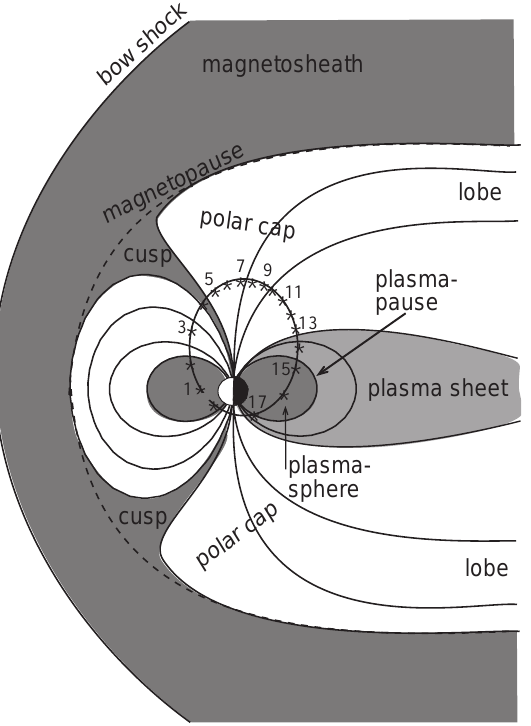
Fig. 1. Schematic drawing of the Earth’s magnetosphere in the noon-midnight meridian. A solid line presents a Polar trajectory; asterisks give the spacecraft’s position at one-hour